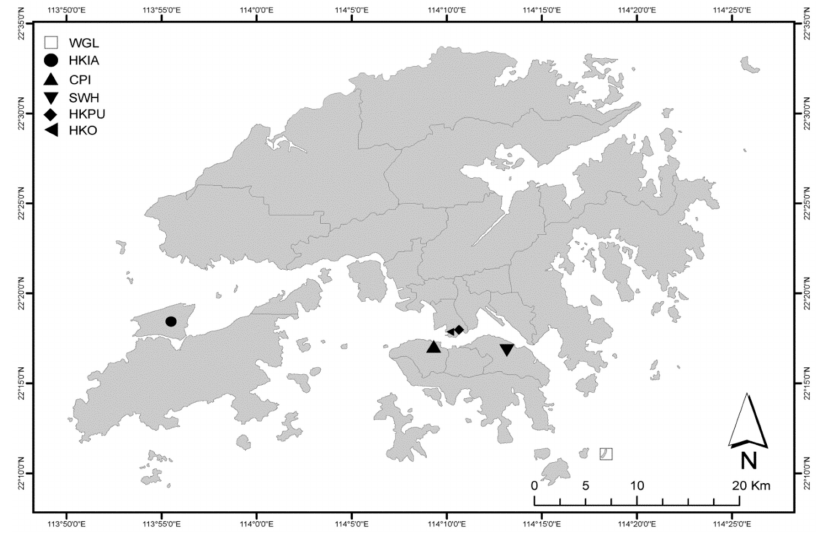
Figure 1. Study area and locations of the visibility monitoring